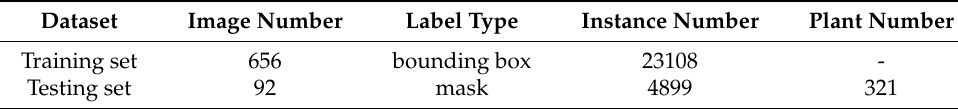
Table 1. The composition of training and testing set after